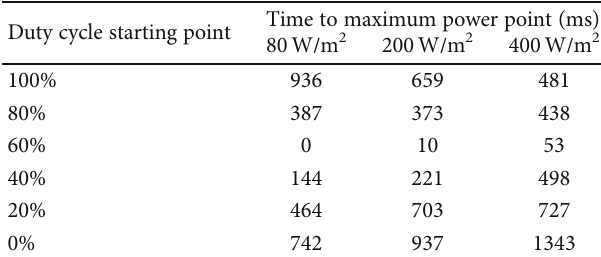
Table 2: Tracking speed test results of